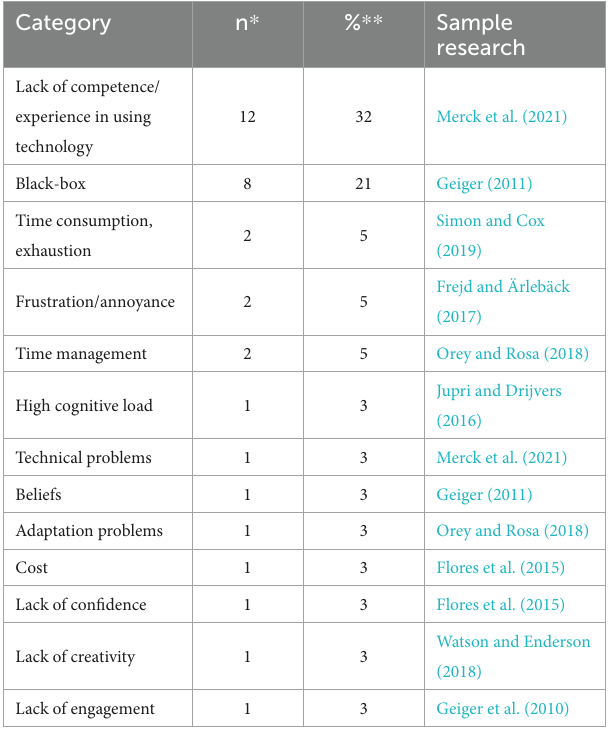
TABLE 7 Technology-related challenges in modelling. Category Sample